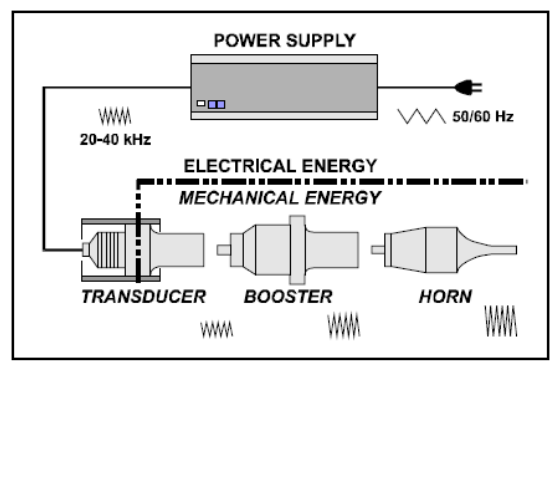
Fig 1. Ultrasonic welding